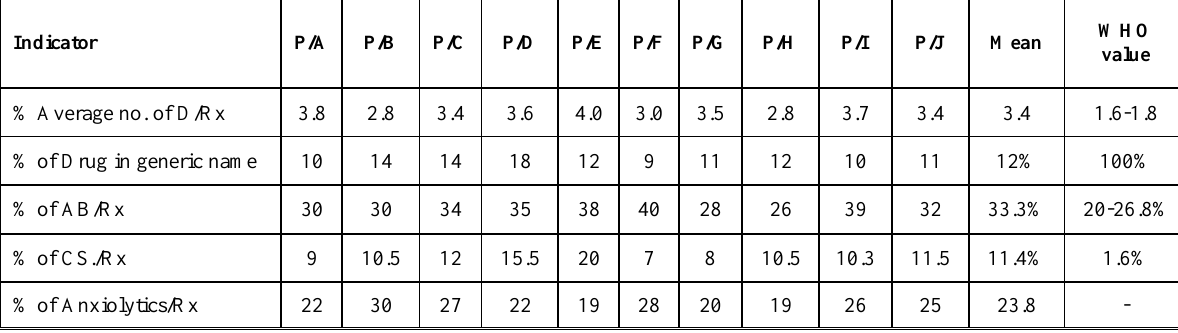
Table 2:The values of each prescribing indicator for 10 pharmacies with the mean & the WHO standard value.